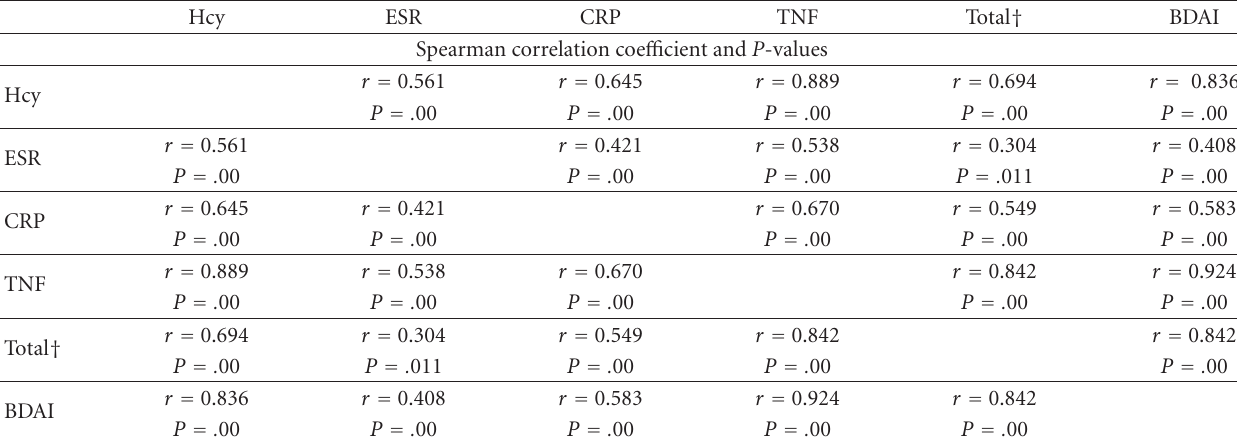
Table 2: The relationship between